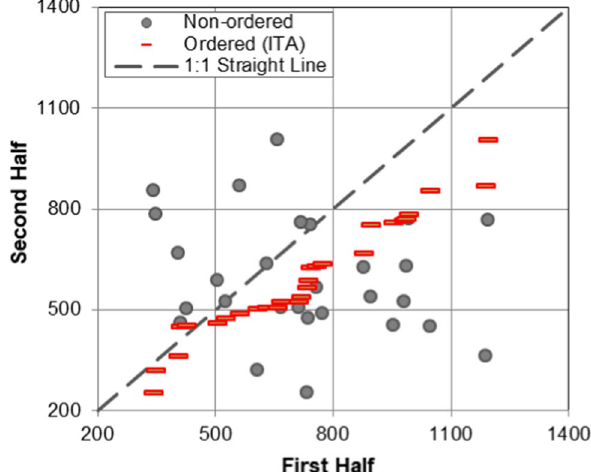
Fig. 3 Possible trend situations according to Şen-ITA